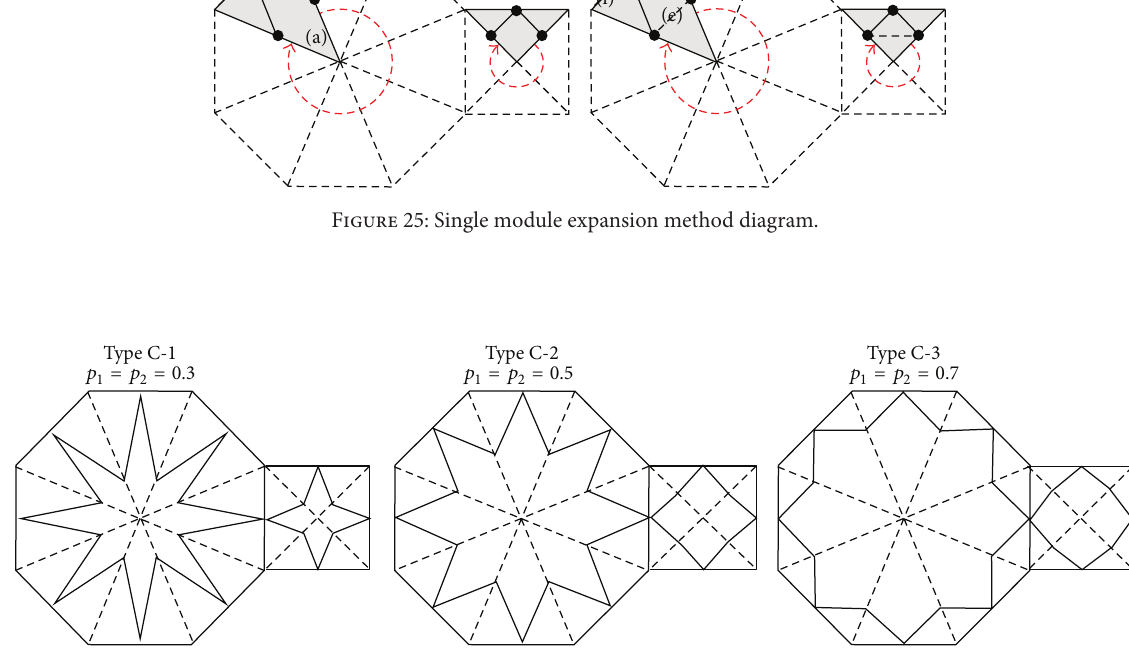
Figure 26: Examples of basic variations: Type